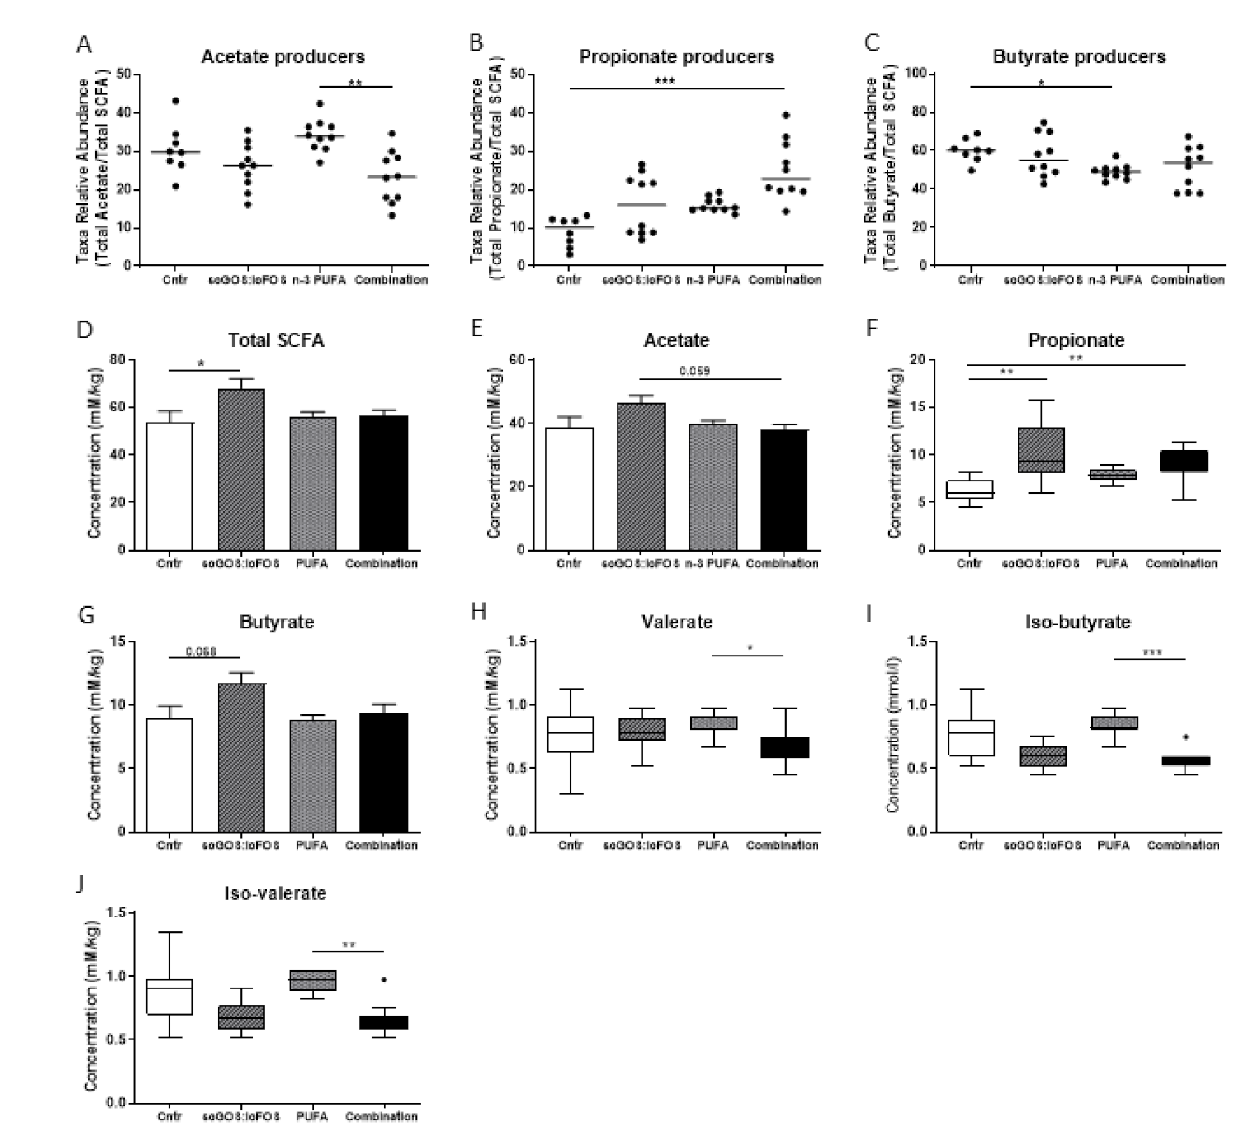
Figure 5. Caecum content predicted and targeted short-chain fatty acids metabolite concentrations between mice groups. Genera taxa metabolite predictive models depicting the relative abundances of ( A ) acetate- ( B ) propionate- and ( C ) butyrate-producing taxa were examined in the control and dietary mice groups. Targeted SCFA and BCFA graphs depict ( D ) total SCFA (mM/kg); ( E ) acetate (mM/kg); ( F ) propionate (mM/kg); ( G ) butyrate (mM/kg); ( H ) valerate (mM/kg); ( I ) iso-butyrate (mM/kg) and ( J ) iso-valeric acid (mM/kg) in the mice groups. ( A – C ): Data shown as individual data points and median. ( D , E , G ): Data shown as the mean +/ − SEM. ( F , H – J ): Data shown as